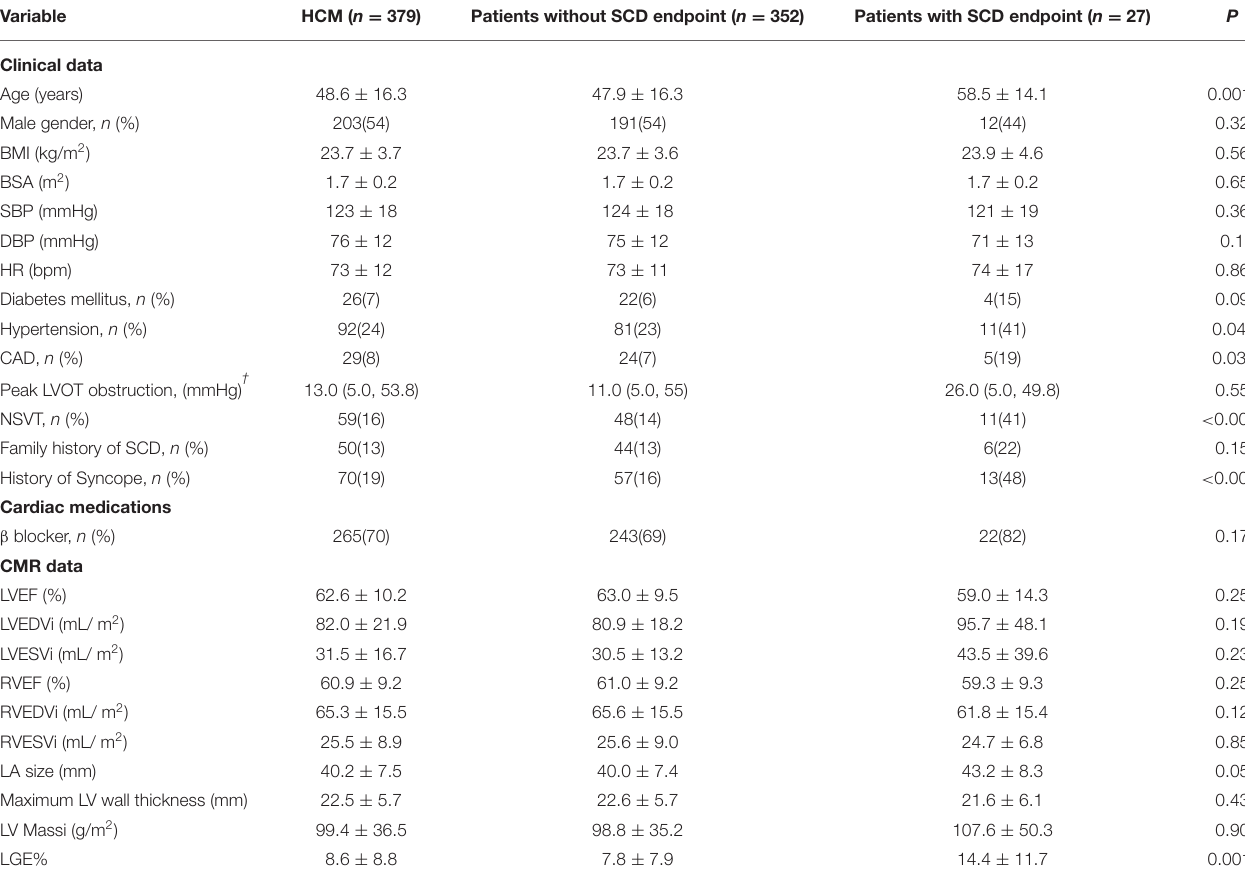
TABLE 1 | Demographic and clinical characteristics in recruited participants with hypertrophic cardiomyopathy. Variable Patients without SCD endpoint ( n = 352) Patients with SCD endpoint ( n =